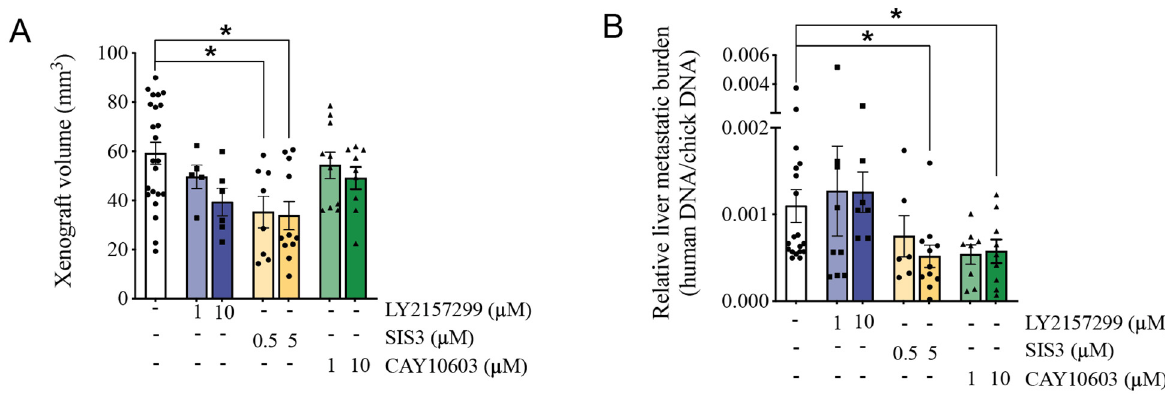
Figure 7. Effect of HDAC6 Inhibition on Tumor Progression. ( A , B ) HT-1080 cells treated with inhibitors selective for TGFBR (LY215799), SMAD3 (SIS3), or HDAC6 (CAY10603) or control vehicle were grown on CAM for 7 days. Tumor xenograft volume ( A ) and chick embryo liver metastatic burden ( B ), as measured by primate Alu-sequence repeats expression relative to chick GAPDH expression, were quantitated. Data are presented as mean ± SEM. Each dot represents one tumor xenograft. * p < 0.05.